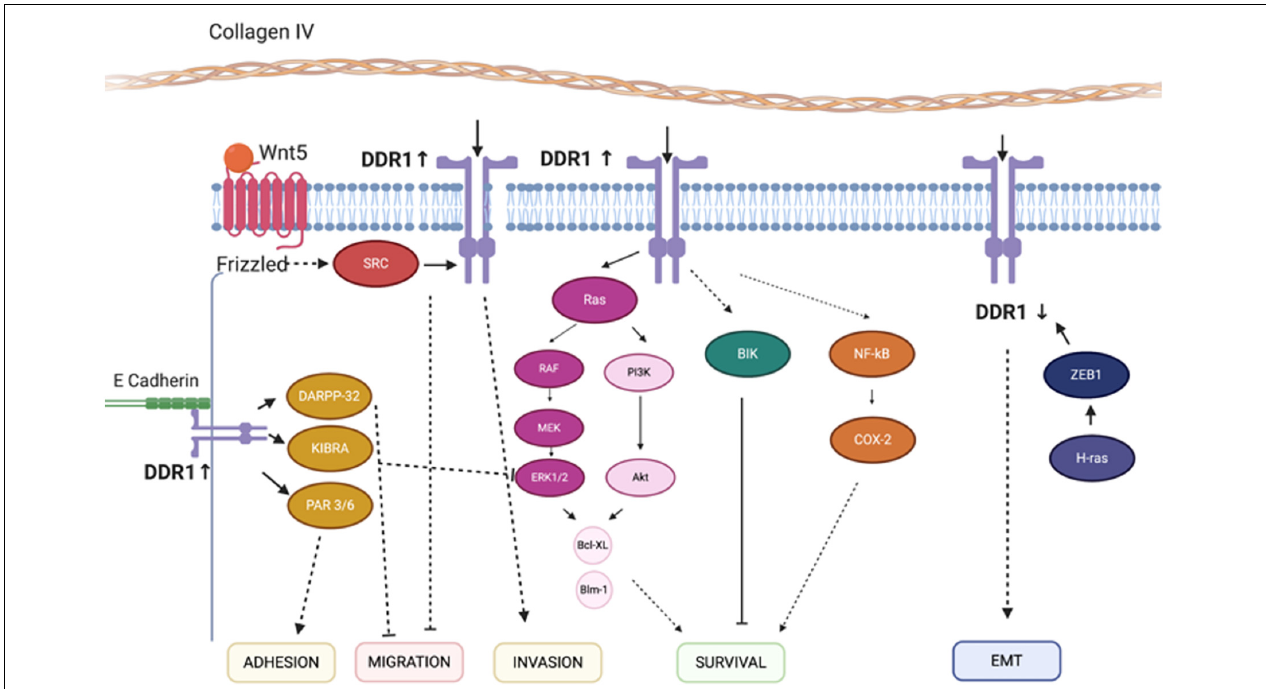
FIGURE 6 | Discoidin domain receptor tyrosine kinase 1-associated signaling pathways. The mechanisms for the effect of ZEB1, COX-2, DARPP-32 and Wnt-5a on the migration, survival, EMT, and invasion regulatory networks are illustrated. Solid lines indicate direct interactions or effects, whereas, dashed lines indicate indirect interactions or effects through one or more intermediate steps. Pointed and flat arrows indicate activating and inhibiting effects, respectively. DDR1, discoidin domain receptor 1; ZEB1, zinc finger E-box-binding homeobox 1; COX-2, cyclooxygenase-2; DARPP-32, dopamine- and cAMP-regulated neuronal phosphoprotein; EMT, epithelial-to-mesenchymal transition; CD9, cluster of differentiation 9; NMHC-IIA, non-muscle myosin heavy chain-IIA; BIK, Bcl-interacting killer; NF- κ B, nuclear factor- κ B; MEK, ERK activator kinase; ERK, extracellular signal-regulated kinase. Figure adapted and modified from Payne and Huang (2014) and Jing et al.